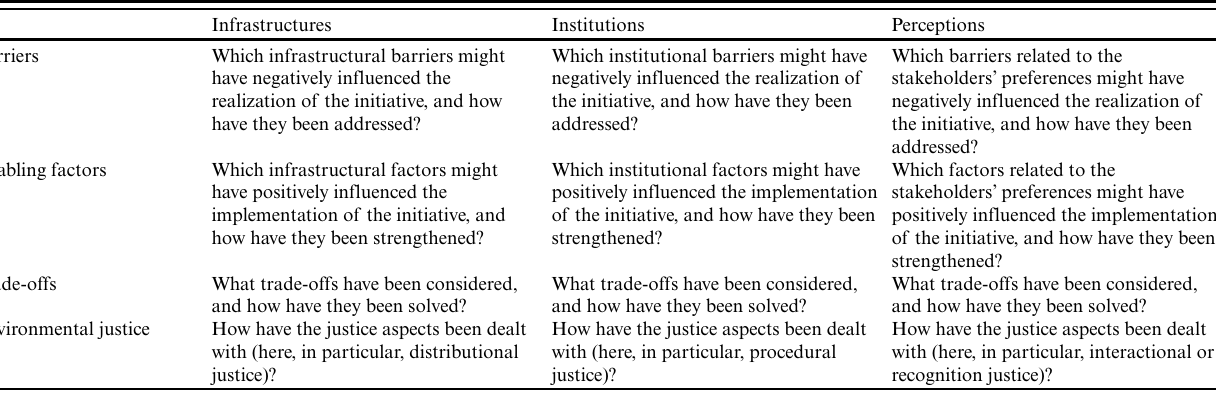
Table 1. ENABLE filters mediating the flow of benefits from GBI to potential beneficiaries translated into an analytical framework for the assessment of GBI-related